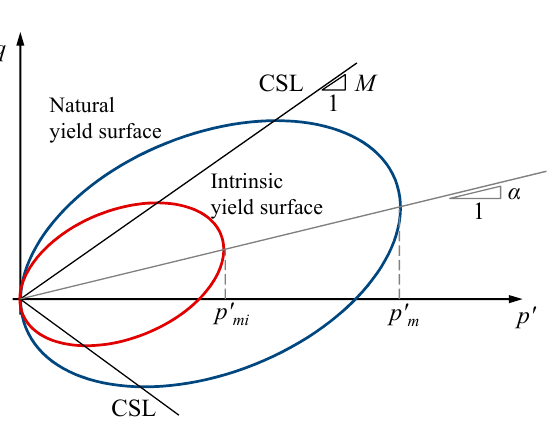
Figure 1. Yield surfaces of the S-CLAY1S model (Modified from [10]).